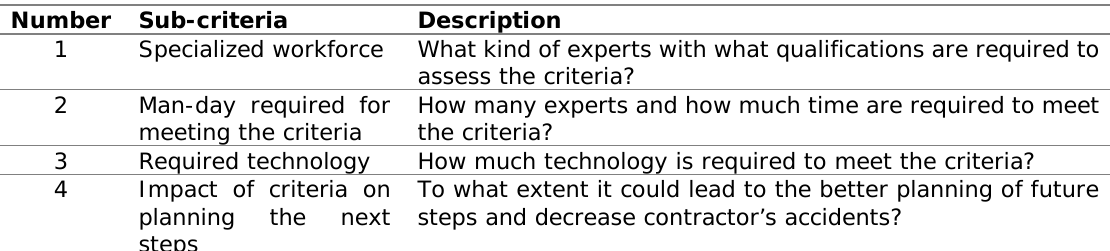
Table 2. Contract separation